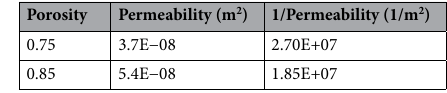
Table 1. Porosity